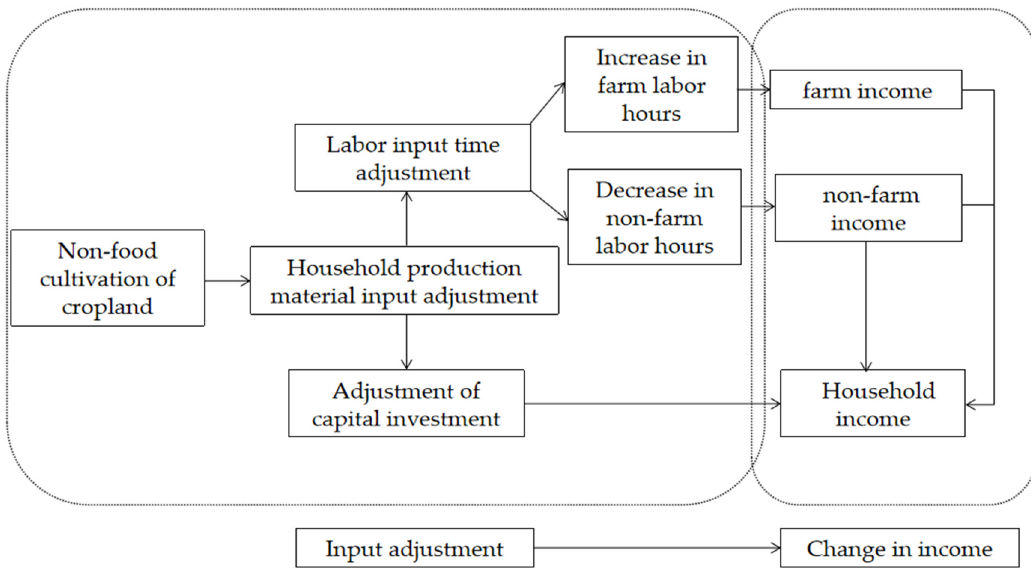
Figure 3. The relationship between non-food cultivation and household income.